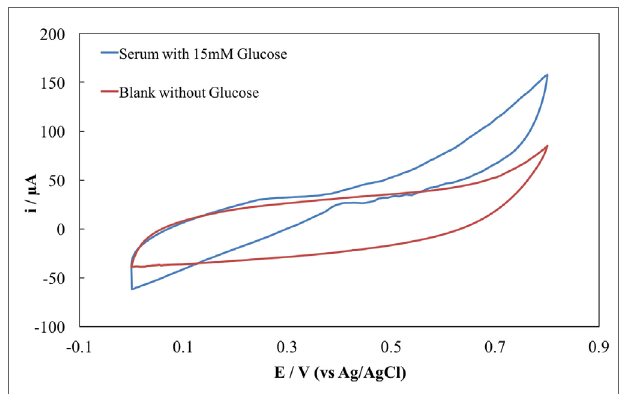
FigUre 2 | cVs of the PQQ-gDh anode in human serum supplemented with 20.89 mM glucose (blue) and glucose-free mimicking solution (red) .